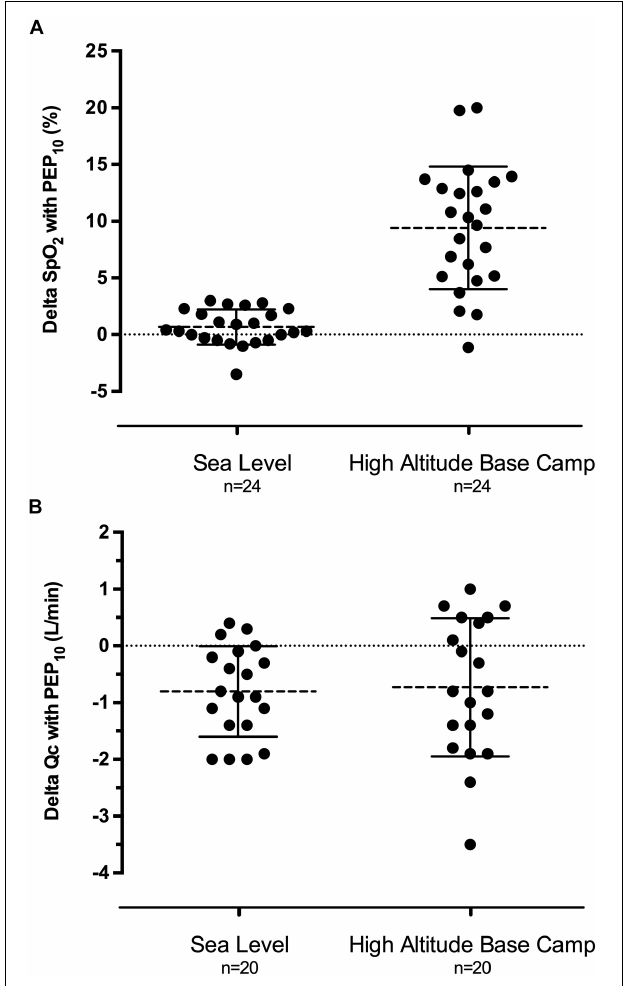
FIGURE 2 | Individual modifications of arterial pulse oxygen saturation ( A, delta SpO 2 ) and cardiac output ( B, delta Qc) induced by 25 min of PEP 10 breathing compared to PEP 0 at sea level in normoxia and the day after reaching high altitude base camp at 5,085 m. Mean SpO 2 increase was statistically significant at high altitude ( P < 0.001) and mean Qc decrease was statistically significant both at seal level ( P < 0.001) and at high altitude ( P =